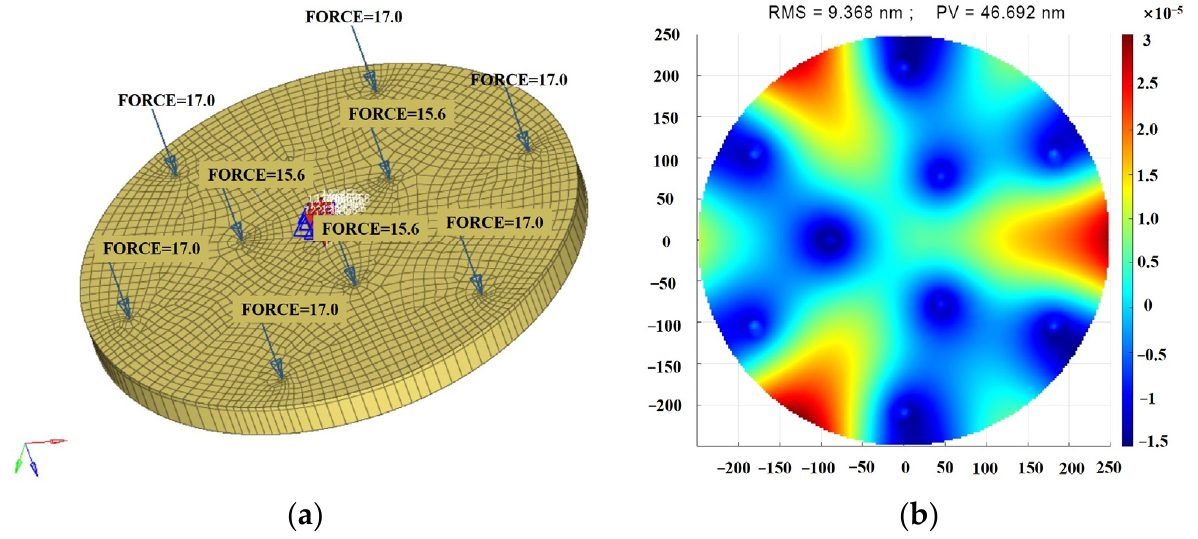
Figure 5. ( a ) Finite element model of the 500 mm diameter mirror; ( b ) finite result of the 500 mm mirror’s deformation.